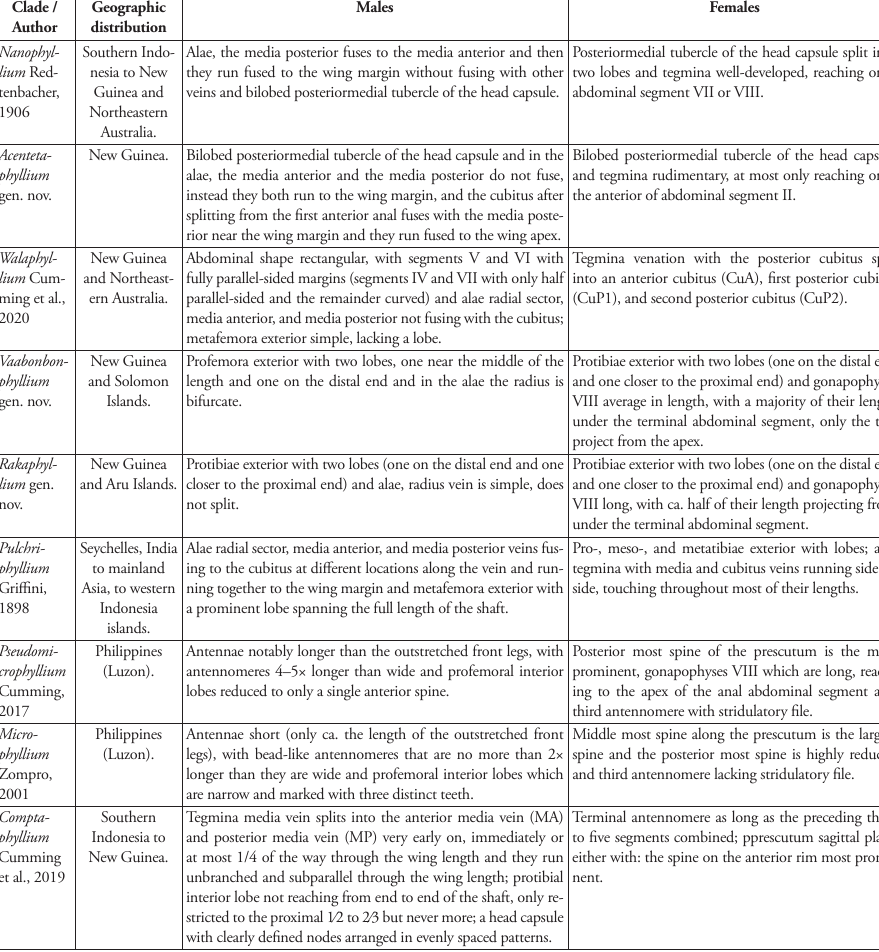
Table 1. Summary of key morphological features for differentiating phylliid genera and well as the clade geographic